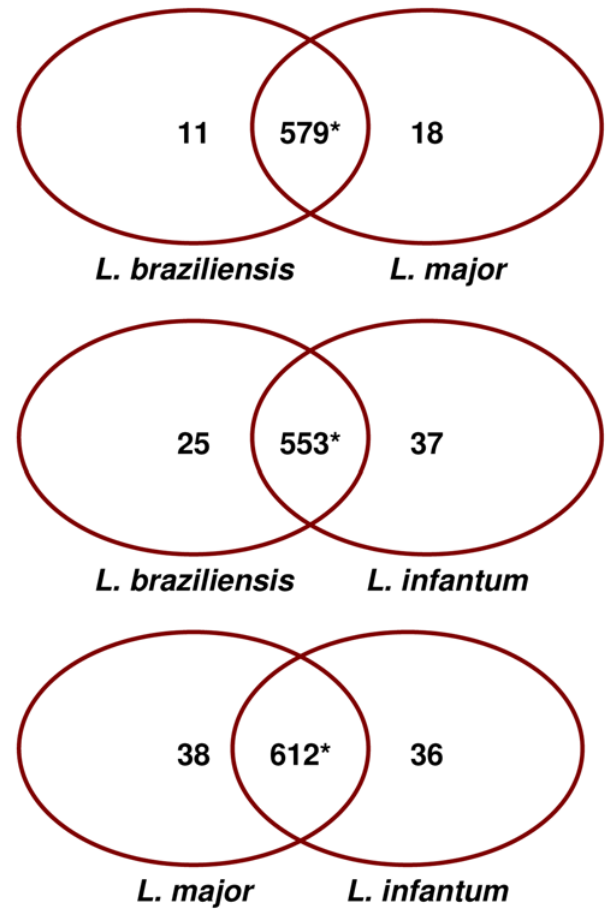
Figure 3. Differential expression of amastigote genes between Leishmania species. Venn diagrams showing pairwise comparisons of amastigote RNA expression from the three target Leishmania species; the number of genes with increased expression ( . 1.7-fold, p , 0.05) in each species is indicated. *Genes that show no significant difference in expression between species.